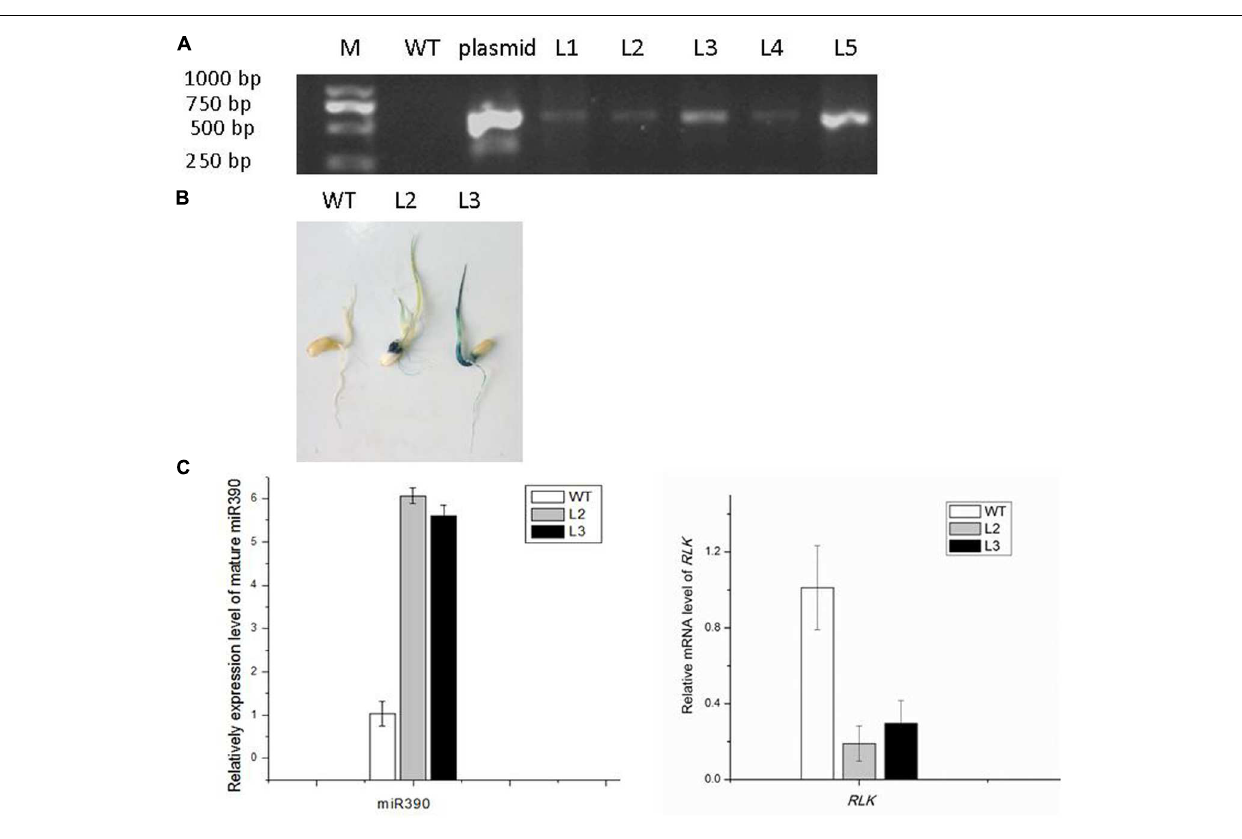
FIGURE 3 | Confirmation of 35S:MIR390 transgenic rice plants. (A) Genomic PCR analysis of transgenic rice plants. Genomic DNA was used as the template for PCR. The expected size of the product was 621 bp. Key: M, DNA marker; WT, wild-type plant; L1–L5, transgenic plants. (B) GUS activity analysis of